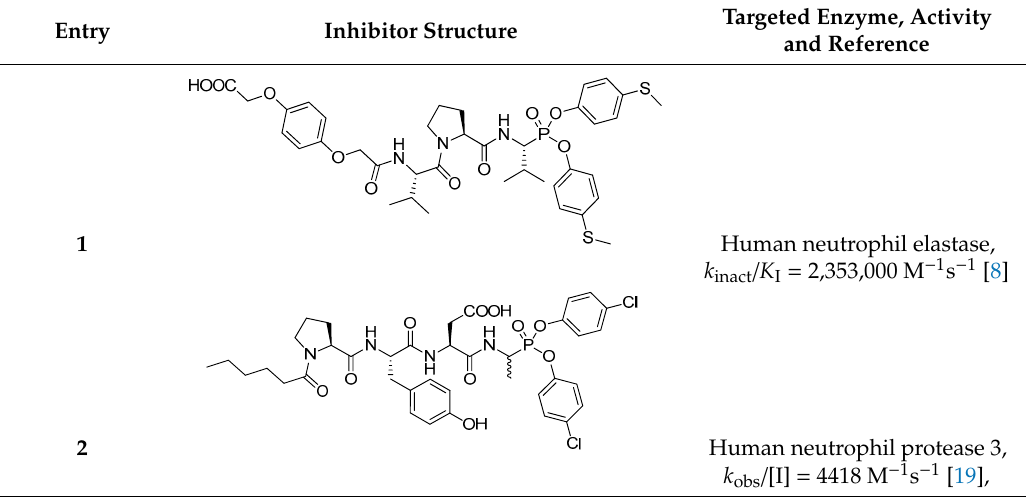
Table 1. A selection of recent achievements in the development of peptidyl diaryl phosphonate inhibitors of serine proteases.